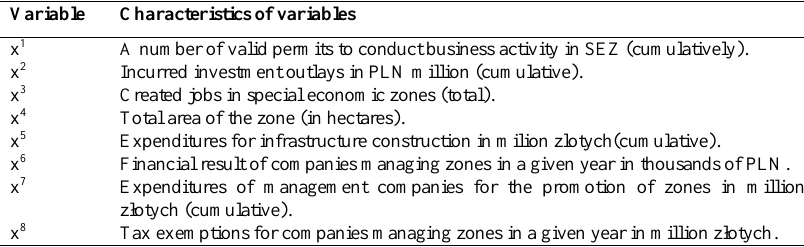
Table 1. Variables describing the subject of the study